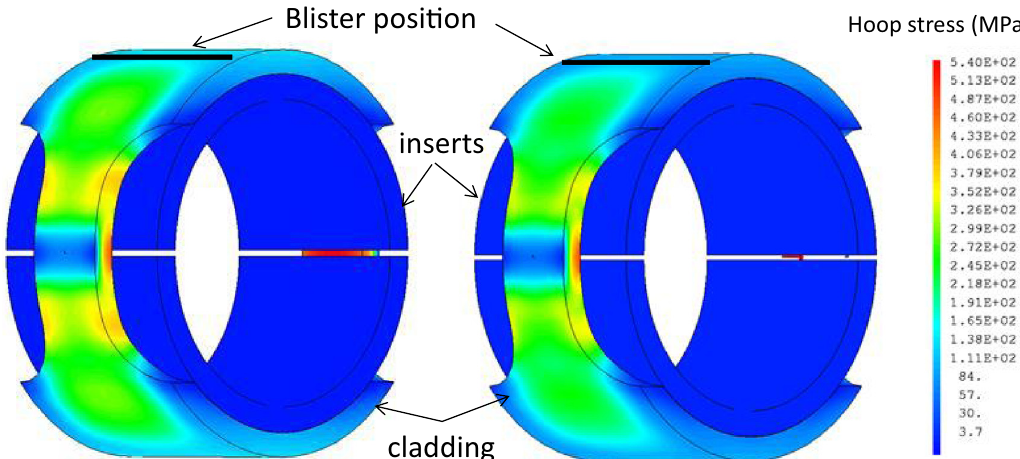
Fig. 2. Hoop stresses calculated at failure time during the PROMETRA test 2468 (left: friction coef fi cient 0.1, right: friction coef fi cient 0.4).